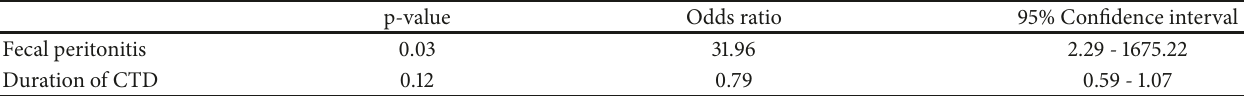
Table 6: Prognostic factors for mortality within 28 days after surgery in patients with connective tissue disease